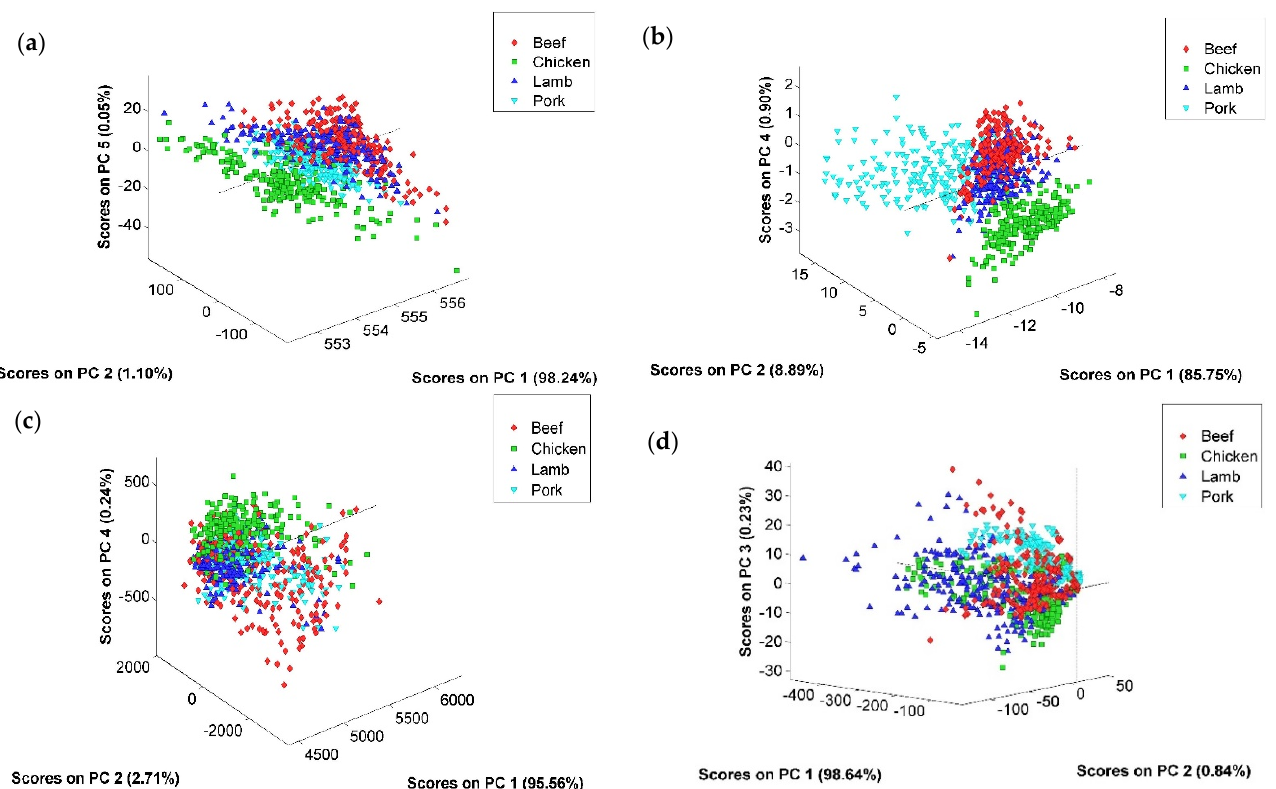
Figure 3. Vis-NIR data (400–1000 nm): ( a ) The PCA score projections of Vis-NIR spectra of intact meat preprocessed with EMSC; ( b ) the PCA score projections of Vis-NIR spectra of ground meat preprocessed with EMSC + 1st derivative. NIR data (900–1700 nm): ( c ) The PCA score projections of NIR spectra of intact meat preprocessed with MSC (mean) + 1st derivative (SavGol); ( d ) the PCA score projections of NIR spectra of ground meat preprocessed with gap segment 2nd derivative.